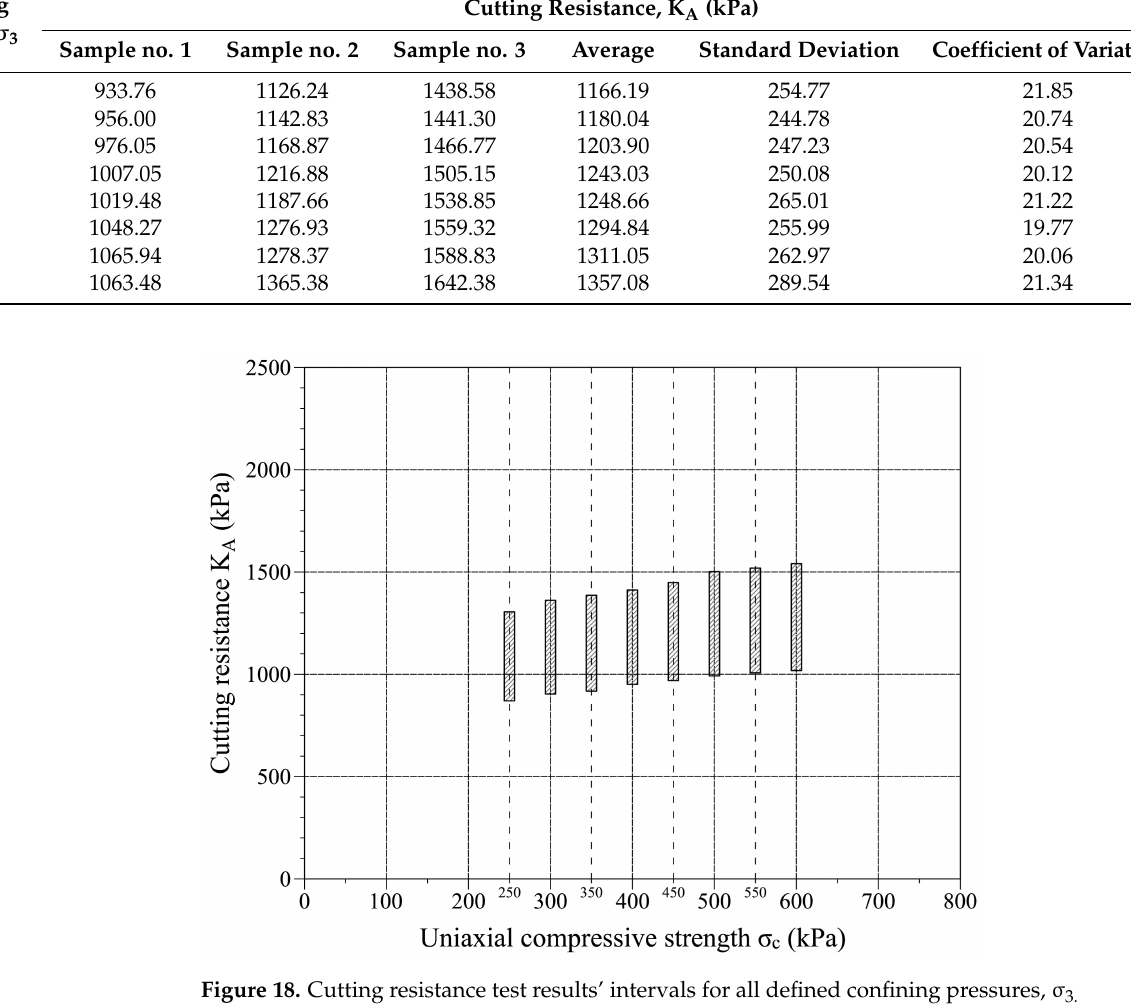
Table 3. Results of cutting resistance tests for all defined confining pressures, σ 3